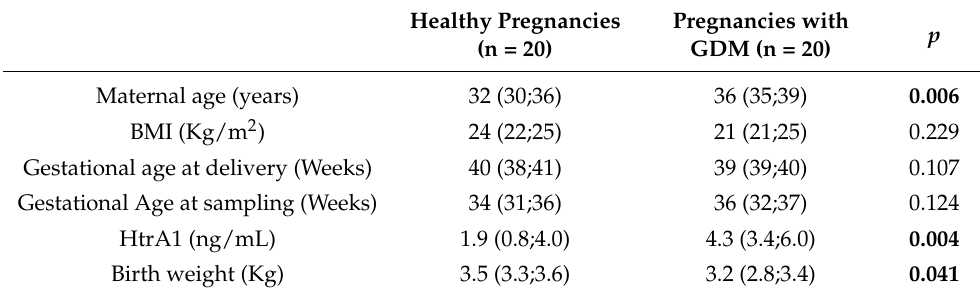
Table 1. Demographic and clinical characteristics according to health status at